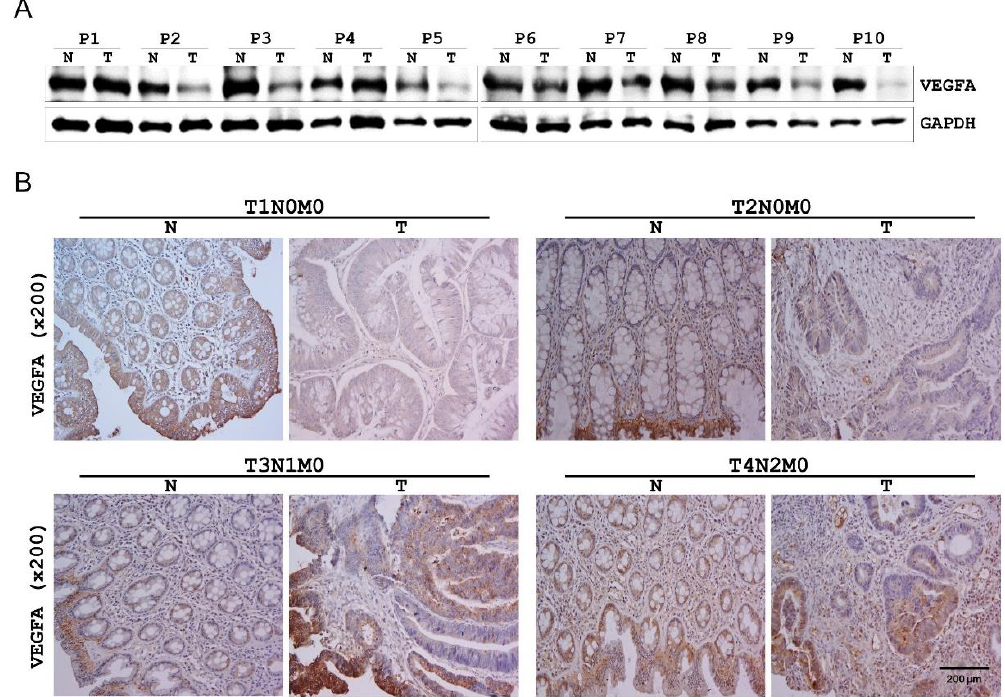
Figure 2. Endogenous VEGFA levels in human colorectal cancer (CRC) tissues. ( A ) The expression levels of VEGFA were validated using 10 pairs of human CRC and adjacent healthy colorectal samples by western blotting. The expression levels were normalized to that of Glyceraldehyde 3-phosphate dehydrogenase (GAPDH). ( B ) VEGFA immunostaining in the TNM Classification of Malignant Tumors (TNM) stage human CRC and adjacent healthy colorectal samples (200× magnification). These experiments were independently performed three times in duplicate.